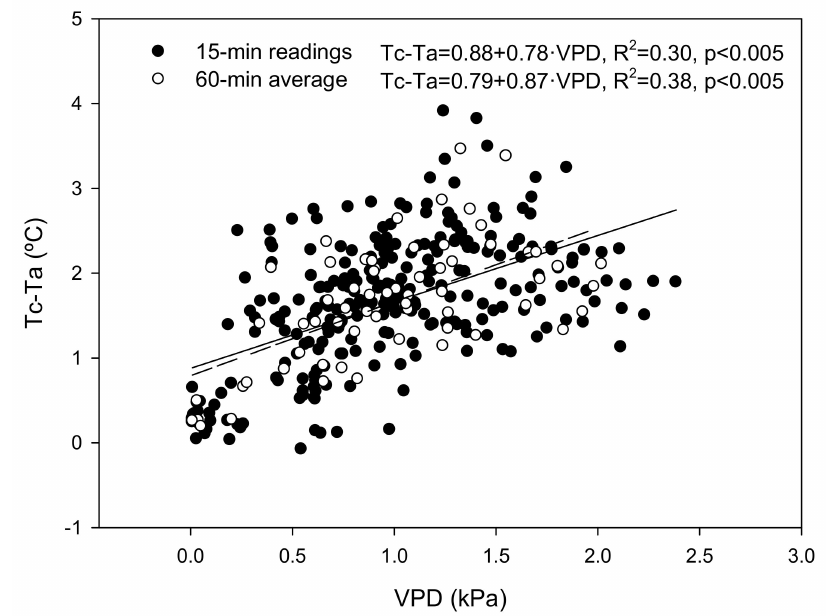
Figure 3. Example of relationship between Tc-Ta ( ◦ C) and VPD (kPa), using 15-min readings and 60-min averaged obtained at 8.00 GMT for full-irrigated trees (TW-FI) during the experimental period in 2017. Solid line and dash line correspond to linear regressions for 15-min readings and for 60-min average,